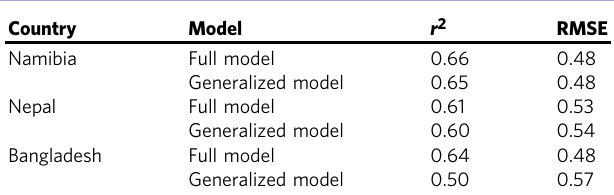
Table 3 Cross-validation statistics based on a random 30% test set of data for models using all CDR features (Full model) and a common set of CDR features (Generalized